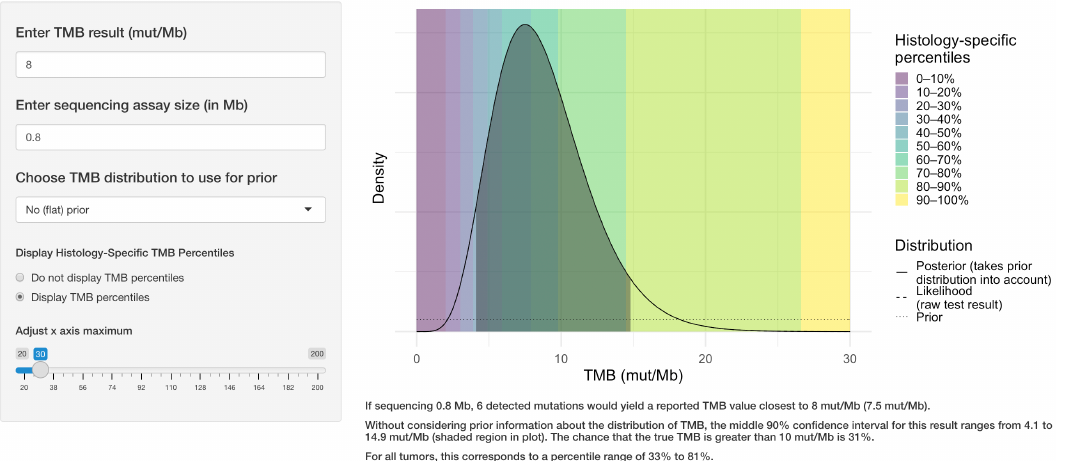
Figure 1. Example of the web application interface. The user selects the target TMB result, the sequencing assay size in megabases, whether to use prior information regarding the TMB distribution for the tumor type, and whether to display TMB percentile information. The application then displays the central 90% confidence interval for the true TMB result and calculates the likelihood that the true result is greater than 10 mutations per megabase.